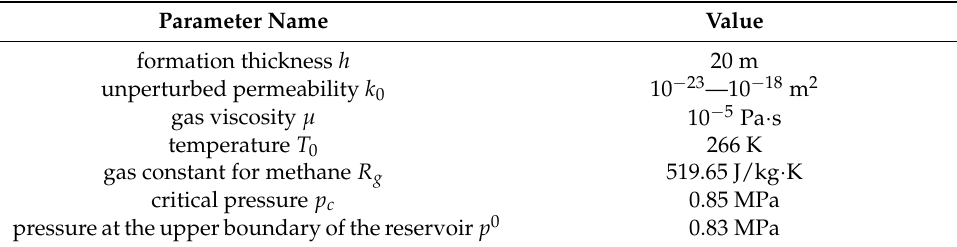
Table 1. Parameter values used to calculate gas flow